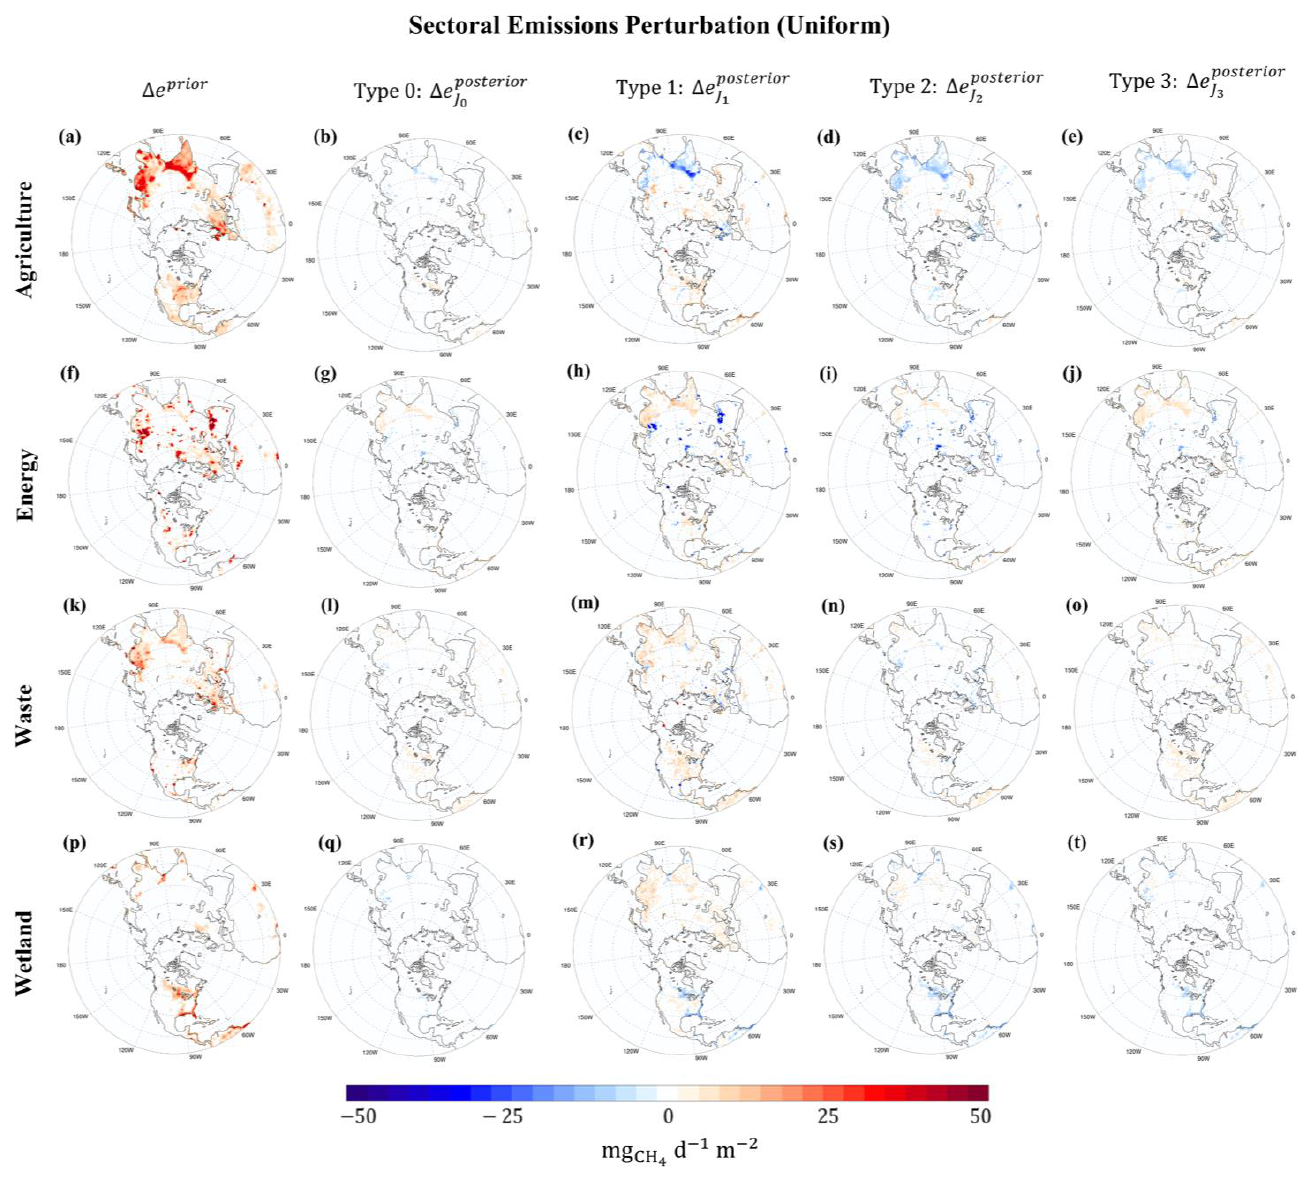
Figure 5. ( a – e ) The prior – true emissions and comparison of the posterior against the true emissions for the only perturbed agriculture sector, ( f – j ) only perturbed energy sector, ( k – o ) only perturbed waste sector, and ( p – t ) only perturbed wetland sector. The prior emissions are generated using 50% uniform perturbation. Type 1 OSSE uses ( c f ) and ( R ). Type 2 performs with analysis initial ( c a ) 1 1 and ( R ). Type 3 OSSE operates with analysis initial ( c a ) and forecast of analysis error covariance 1 ( H o P f ( A 1 ) H o T ), and Type 0 OSSE works with analysis initial ( c a ) and forecast of analysis error 1 covariance with model error ( H o P f ( A 1 , Q ) H o T